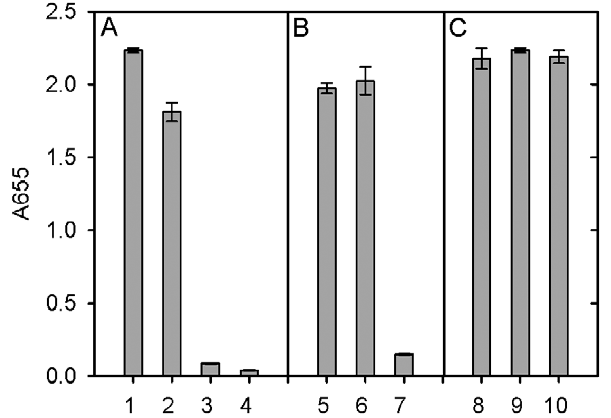
Figure 6. ELISA analysis of the interaction between PAT-SM6 and GRP78. The concentration of GRP78 used to coat the wells was 30 m g/mL. A: Primary antibodies used were PAT-SM6 (lanes 1 and 3), anti-GRP78 (lane 2) and control isotype IgM antibody (lane 4). In lane 3 the initial coating step with GRP78 was omitted. B: Primary antibody used was PAT-SM6. Incubations were performed in 20 mM sodium phosphate buffer with no added NaCl (Lane 5), 140 mM NaCl (lane 6) and 500 mM NaCl (lane 7). C: Primary antibody used was PAT-SM6. Incubations were performed in 20 mM sodium phosphate buffer, 140 mM NaCl at pH values of 6 (lane 8), 7.4 (lane 9) and 8 (lane